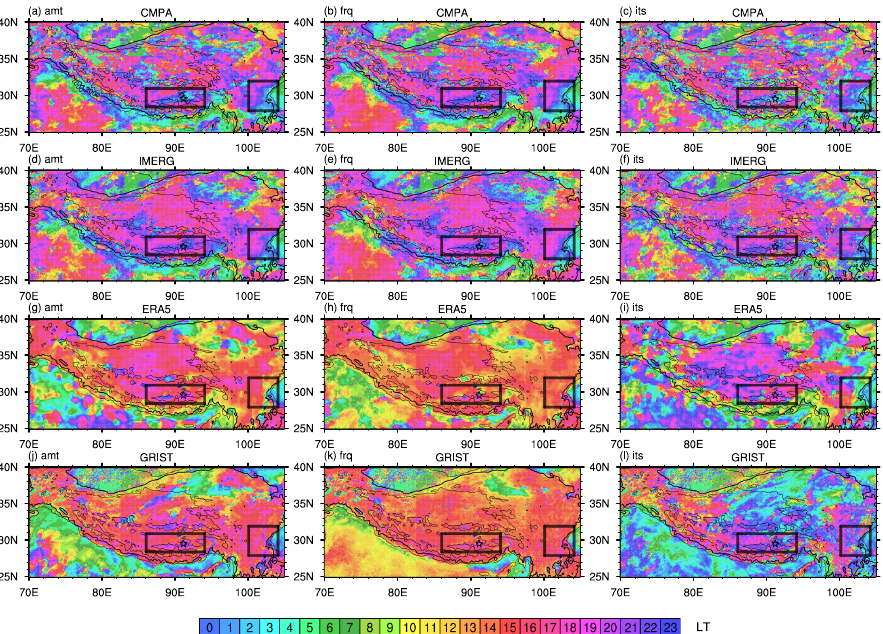
Figure 5. Spatial distribution of the diurnal peaks (LT, left: amount, middle: frequency, right: intensity) derived from CMPA ( a – c ), IMERG ( d – f ), ERA5 ( g – i ), and GRIST ( j – l ). The pentagram indicates the location of Lhasa. The thick black contour depicts terrain heights of 2000 m, and the thin black contours represent 1000 and 4750